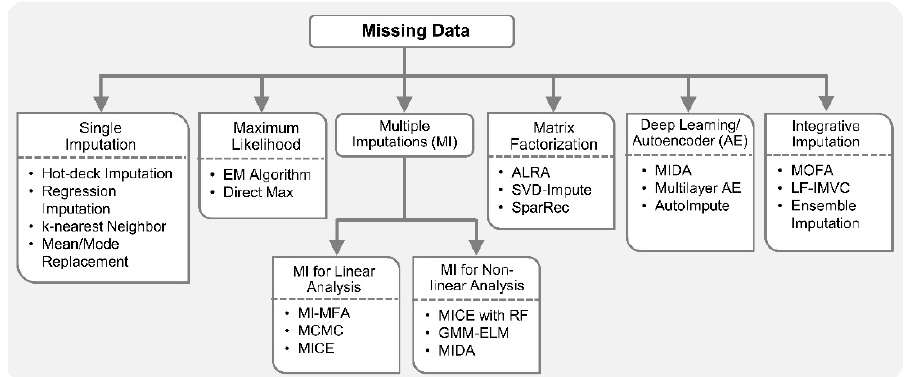
Figure 3. Machine learning with missing data. Conventional single imputation methods for handling missing data include replacement with mean or mode values, hot-deck imputation, regression imputation, k -nearest neighbor, etc. Maximum Likelihood approaches including those based on an expectation-minimization (EM) algorithm and Direct Maximization have attractive statistical properties compared to the conventional methods that often result in biased parameter estimates. Multiple imputation (MI) methods like Markov-chain Monte Carlo (MCMC) and multivariate imputation by chained equation (MICE) are also statistically robust, compared to conventional single imputation methods, as they take into account the uncertainty in the imputed values. MI for multiple factor analysis (MI-MFA) tackles the missing data problem in multi-omics analysis by performing MI based on hot-deck imputation. MI for nonlinear analysis can be performed using random forest (RF) and extreme learning machine (ELM). Adaptively-thresholded low-rank approximation (ALRA), singular value decomposition (SVD)-impute and SparRec methods employ matrix factorization for data imputation. In addition, imputation methods based on autoencoder and deep learning like denoising autoencoder-based MI (MIDA), AutoImpute and multilayer autoencoder (AE) have been proposed for high-dimensional datasets with missing data. Recently, integrative imputation methods such as ensemble regression imputation, multi-omics factor analysis (MOFA) and Late Fusion Incomplete Multi-View Clustering (LF-IMVC) are also